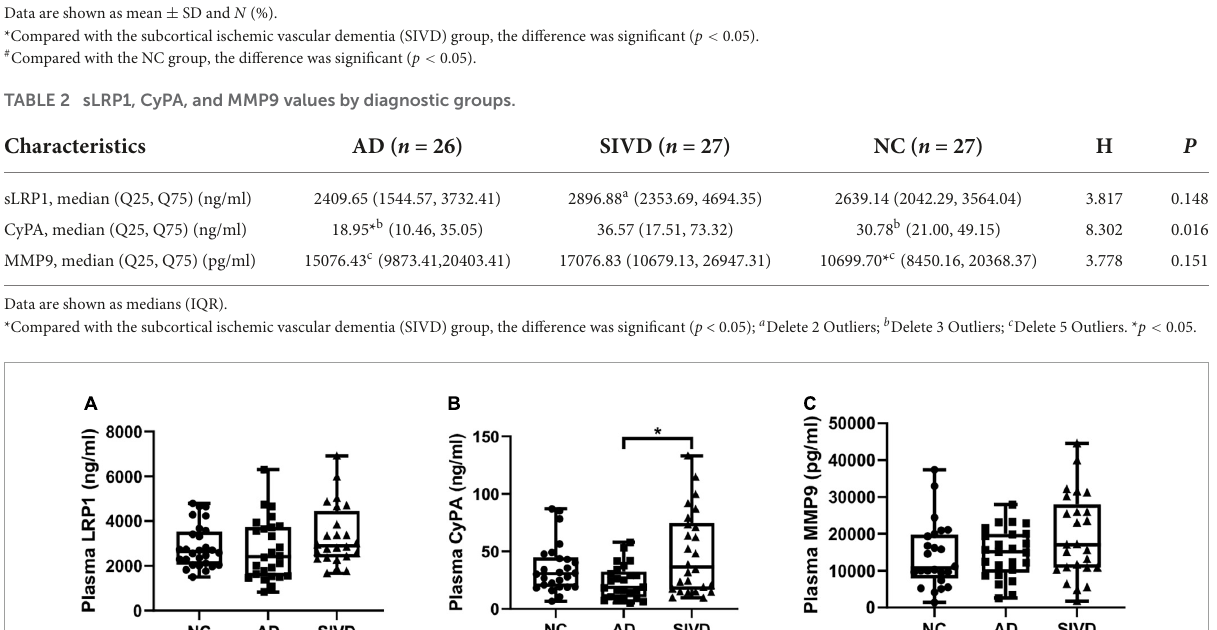
test. Categorical data were presented as proportions, and among groups were compared using the chi-square test. The Spearman correlation analysis was performed to assess the correlation between two quantitative variables, adjusted for age, sex, and education. The diagnostic value of AD and SIVD was estimated by the area under the curve (AUC)